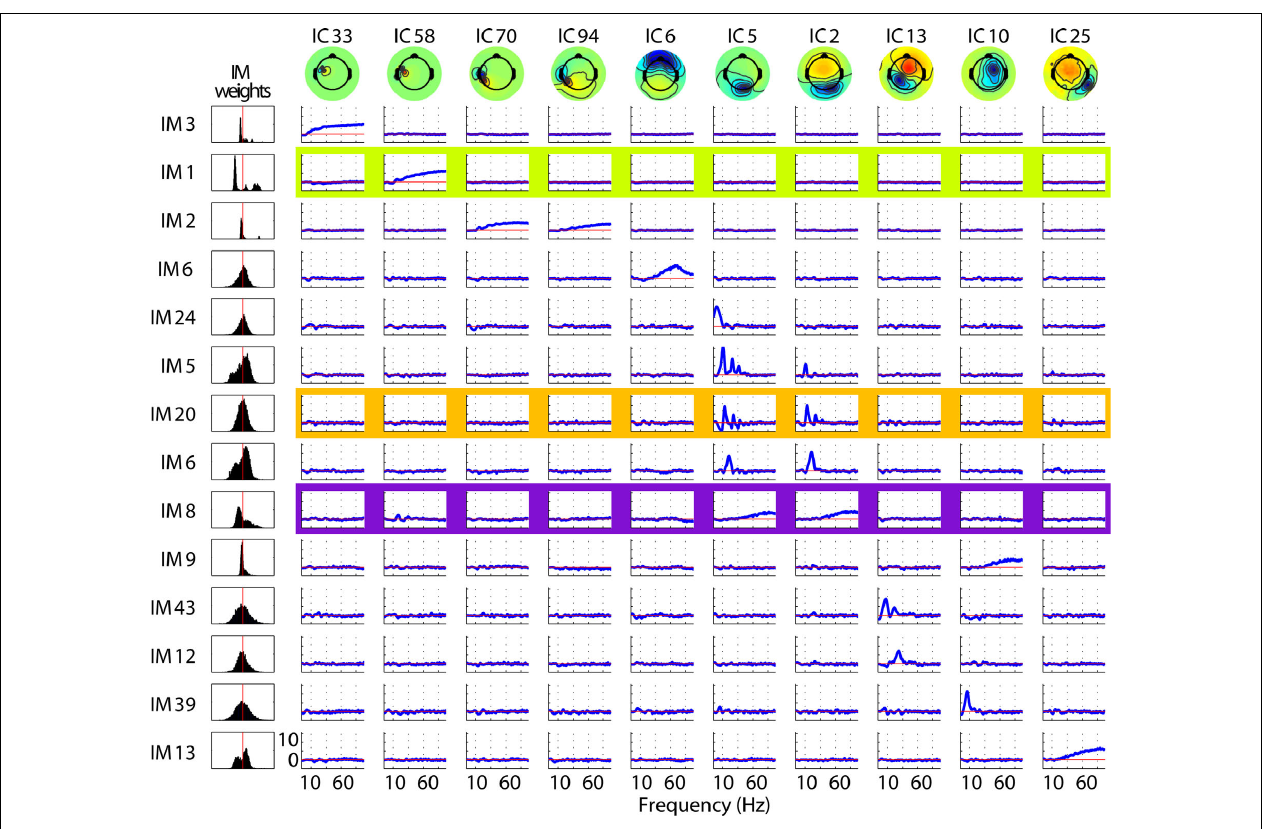
FIGURE 2 | Typical single-subject decomposition of log-spectral power modulations across an hour-long experimental session. The 14 IMs visualized here (14 rows) represent major classes of spectral modulation of 10 of the 16 ICs (rightmost 10 columns) entered into the log-spectral decomposition for this subject. The leftmost column shows histograms of the time-window weights for